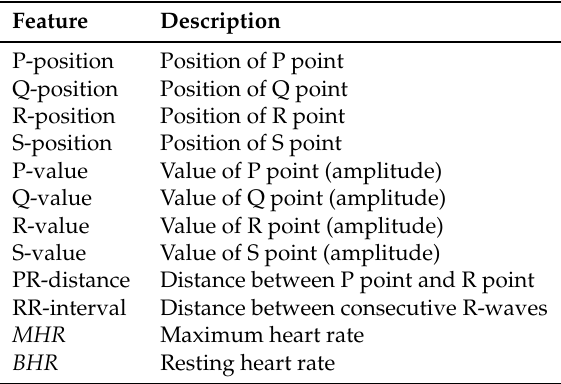
Table 2. Description of the features used for heartbeat